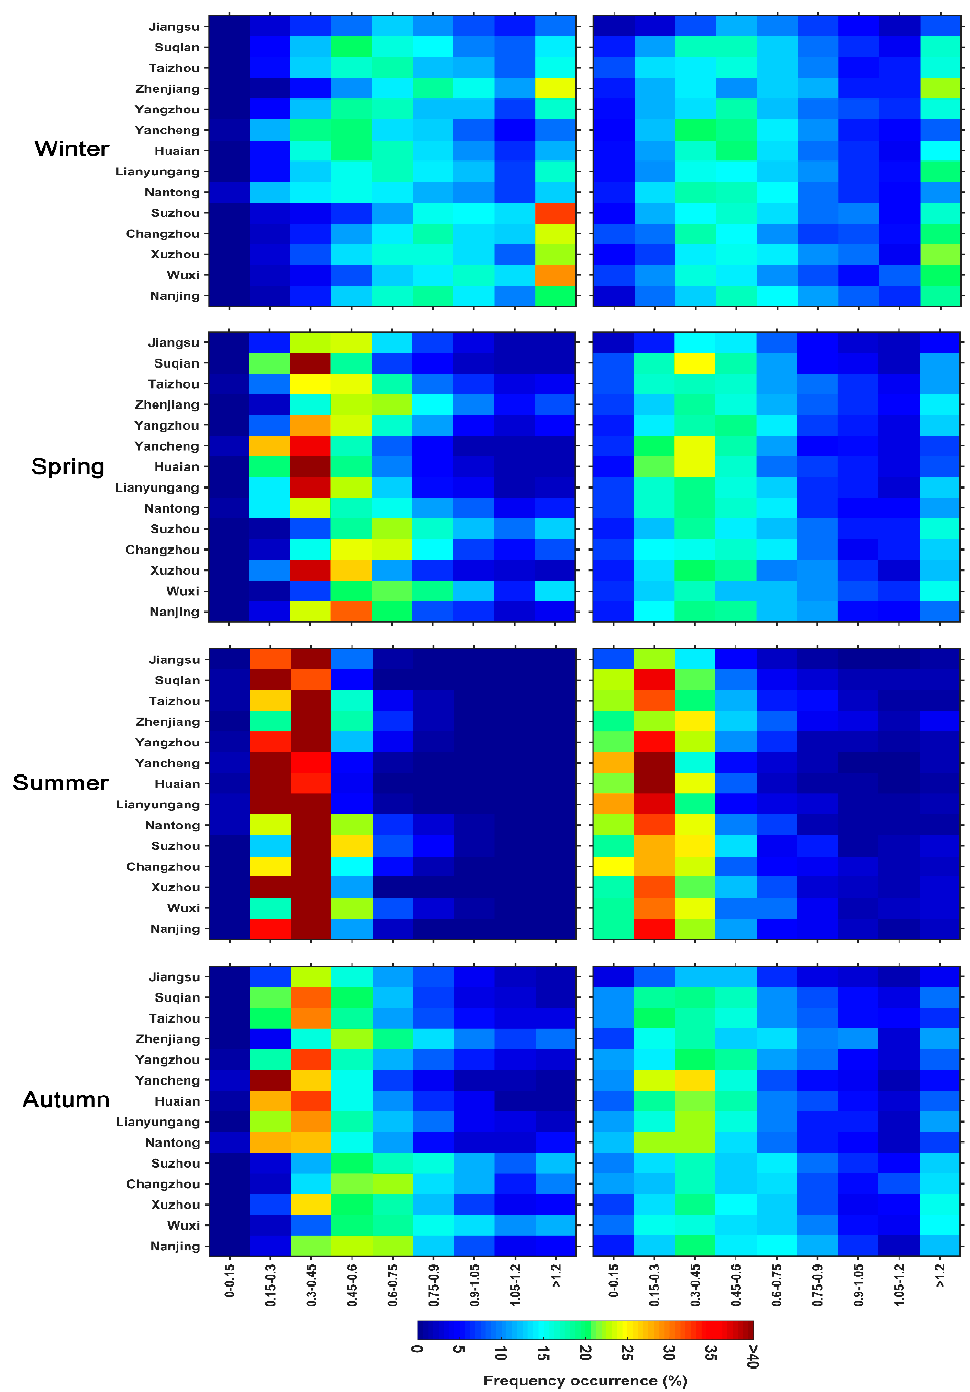
Figure 3. Annual and seasonal frequency distributions of OMI-retrieved total column NO 2 (DU) and SO 2 (DU) in 13 cities of Jiangsu Province from 2005 to 2020.